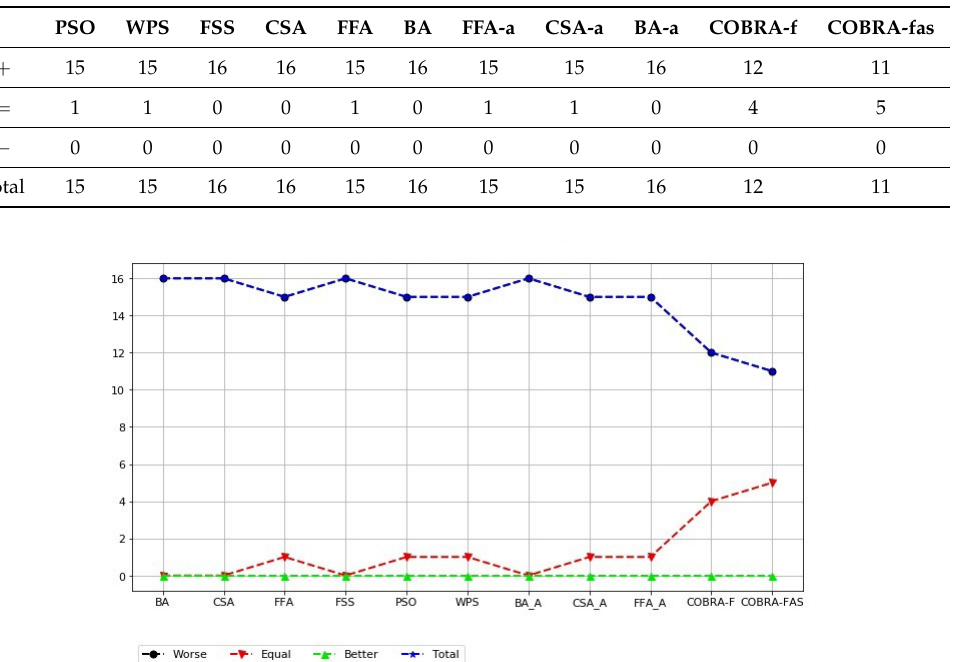
Table 8. Results of the Mann-Whitney statistical test with p = 0.01 for SET-3, comparison of COBRA-SHA with other approaches.